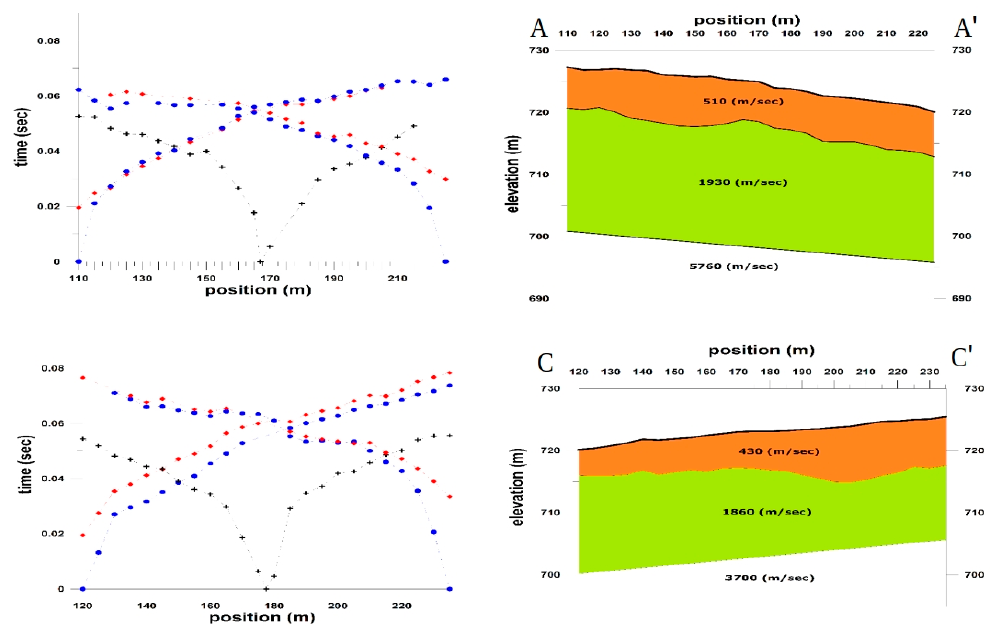
Figure 9. Seismograms from the C - C’ refraction line showing the picked travel-times.